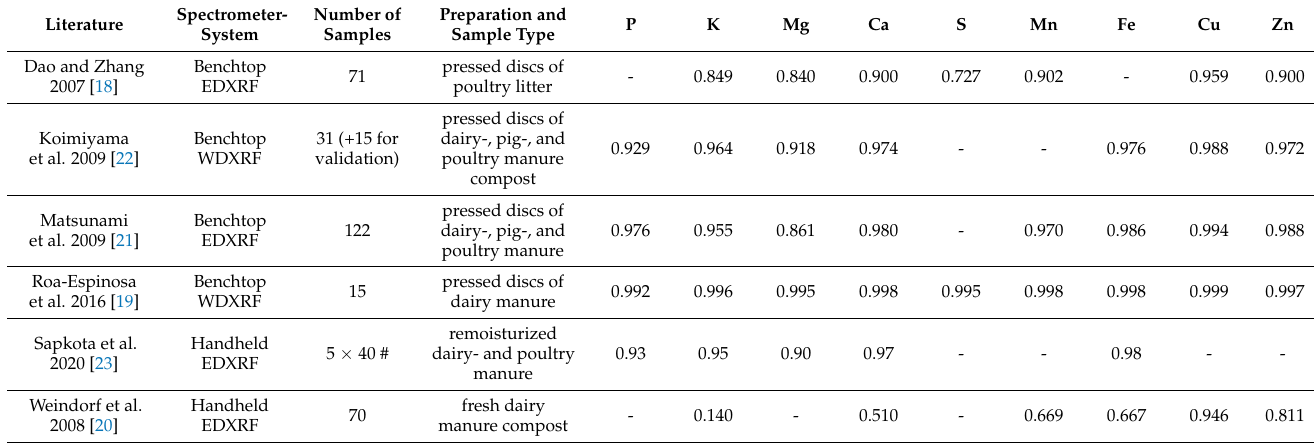
Table 4. Comparison of R 2 values found in the literature for selected elements (EDXRF = energy dispersive XRF detector; WDXRF = wavelength dispersive XRF detector); # 40 samples with 5 different dry matter contents,